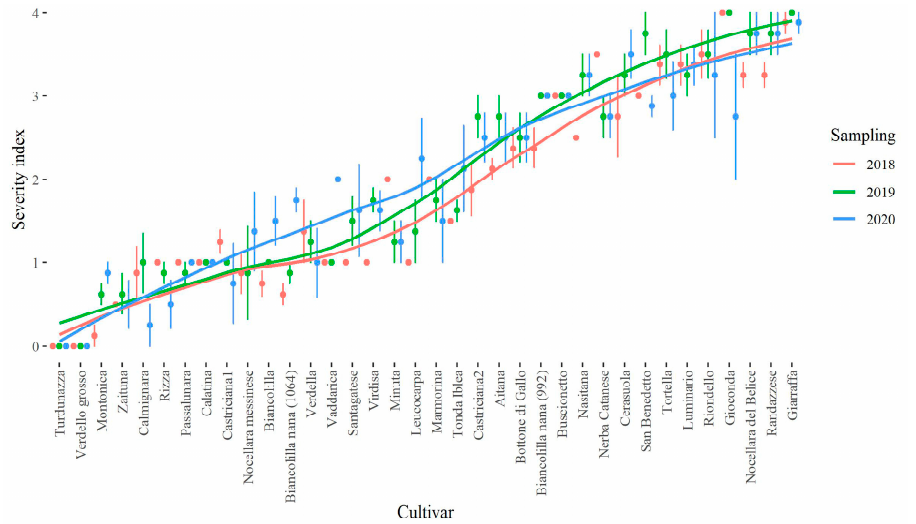
Figure 3. Disease intensity trend of olive knot disease symptoms of 36 olive cultivars during a 3-year survey (2018–2020). For each cultivar, the standard deviation is shown by error bars. Different colored points and the regression lines of disease intensity in 2018, 2019, and 2020 are also shown.